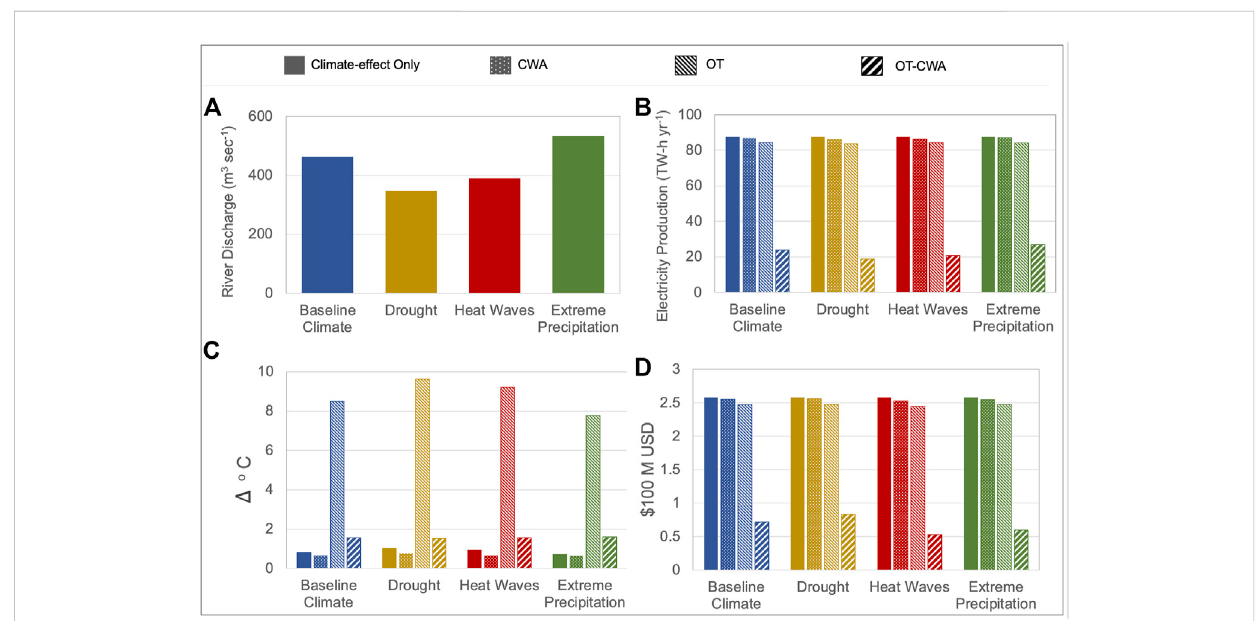
FIGURE 7 The decadal average (2010 – 2019) of outputs from the RCM framework and Economic Valuation Module for the Delaware River Basin, compared using bar graphs for four climate scenarios: Baseline climate (blue), drought (brown), heat waves (red), extreme precipitation (green). Four technology/ policyscenarioswereappliedtoeachclimatewithitscorrespondingvisualcoding: “ Climate-effectOnly ” (solid), “ CWA ” (CleanWaterAct)(dotted), “ AllOT (once-through) Cooling Technology Scenario ” (diagonal stripes-right), and “ All OT Cooling Technologywith CWA Scenario ” (wide diagonal stripes- left). Single and multi-factor scenario results are shown for (A) downstream river discharge (B) annual electricity production (C) basin-averaged increase in river temperature from power plant operation (D) economic valuation of annual electricity